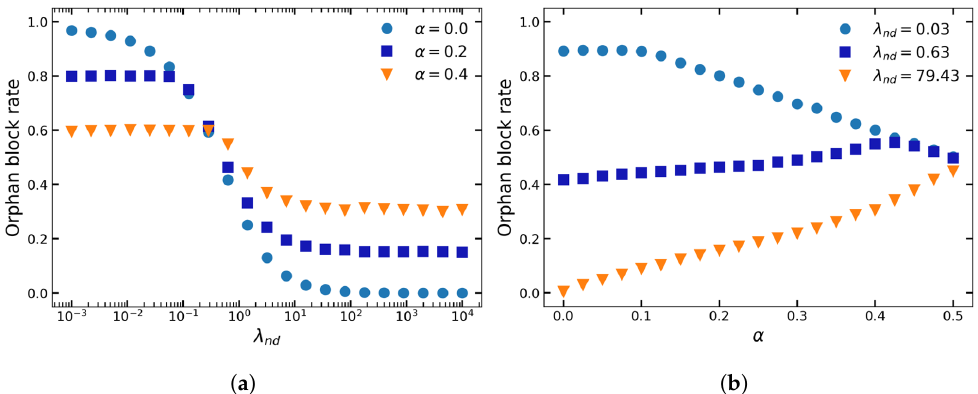
Figure 6. Orphan block rate as a function of: ( a ) latency ( λ nd ) and ( b ) selfish hashing power ( α